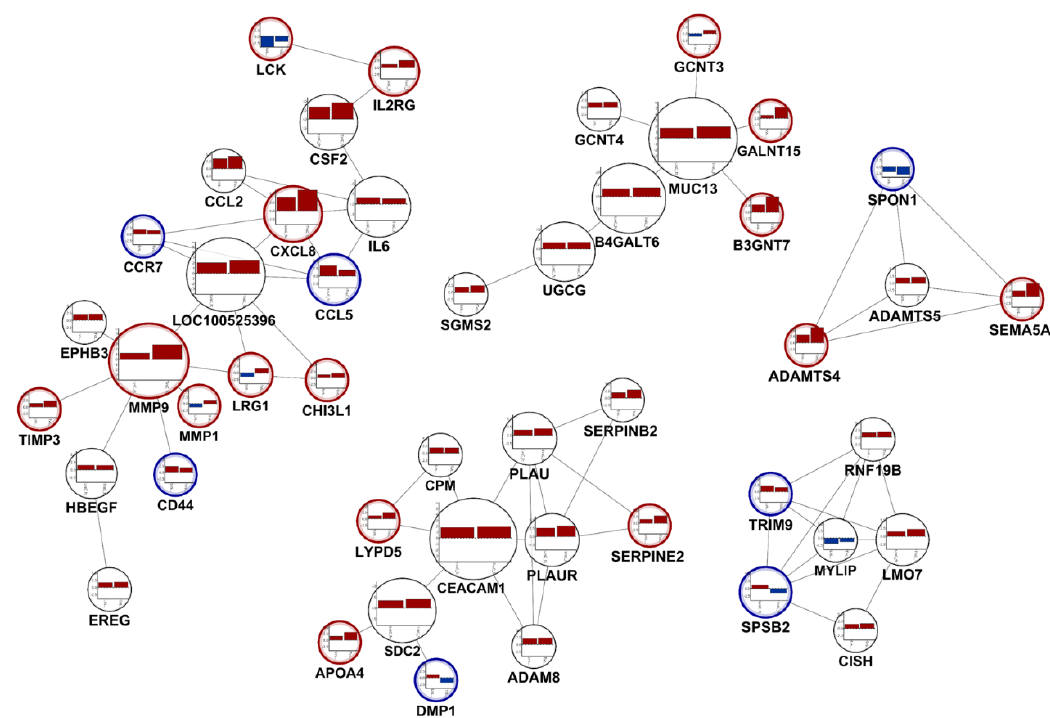
Figure 3. Comparative network with distinguished DEGs and their fold changes between LPA treatment and KA-1002 treatment in swine macrophages. The interactions between DEGs were derived from resources with a combined score of greater than 900 in the STRING database. A node was represented as DEGs. Additionally, fold-changes in each gene are presented as bar charts for LPA treatment vs. control (left bar) and LPA plus KA-1002 treatment vs. control (right bar). Blue circle: upregulated genes by KA-1002 treatment comparing with LPA treatment, Red circle: downregulated genes by KA-1002 treatment comparing with LPA treatment.